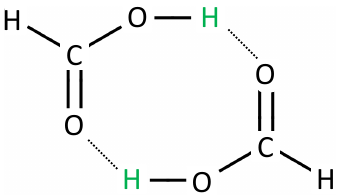
Figure 5. Formic acid dimer. Two formic acid molecules are arranged in a cycle such that the green hydrogen atom can move (along the dotted line) from the donor oxygen atom of one molecule to the acceptor oxygen atom of the other molecule. With the aid of the time-dependent Schrödinger equation, the movement of the electron density during this reaction is computed (results taken from [45]).